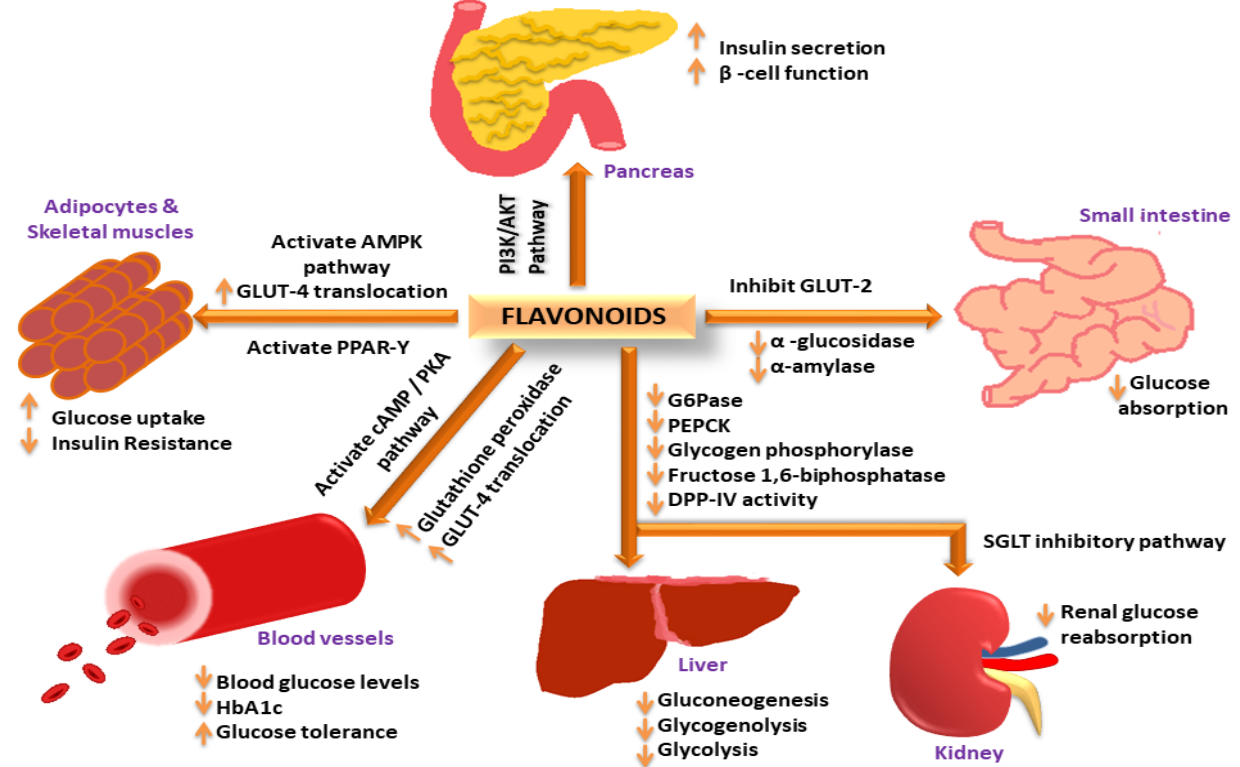
Figure 1. Flavonoids exerting antidiabetic activity via different mechanistic pathways: Flavonoids increase insulin secretion and improve β -cell function via the PI3K/AKT signaling pathway; increase GLUT-4 translocation through AMPK activation to increase glucose uptake in adipose tissues and skeletal muscles; activate PPAR- γ expression to decrease insulin resistance; activate cAMP/PKA pathway to reduce blood glucose levels and improve glucose tolerance; increase glutathione peroxidase activity to reduce HbA1c levels; decrease G-6-Pase, PEPCK, glycogen phosphorylase, fructose 1,6-biphosphatase and DPP-IV activity in liver to decrease gluconeogenesis, glycogenolysis, and glycoslysis; inhibit SGLT pathway in kidney to decrease renal glucose reabsorption; inhibit GLUT-2, α - amylase and α -glucosidase activity to decrease glucose absorption in the small intestine.